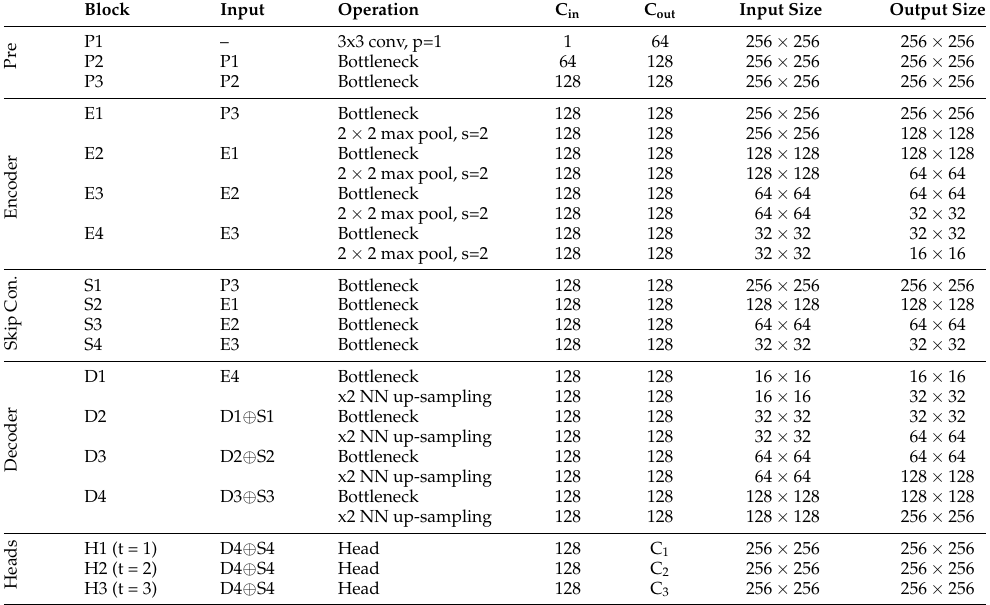
Table A1. Detailed topology of the used multi-task network in the multi-head configuration. The architecture is adapted from the Stacked Hourglass Network by Newell et al. [76]. The bottleneck and head topology are illustrated in Figure A3. (s: stride, p: padding, ⊕ : feature fusion by element-wise addition, NN: